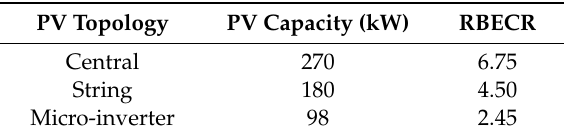
Table 7. Replacing a conventional generation unit by a PV System.